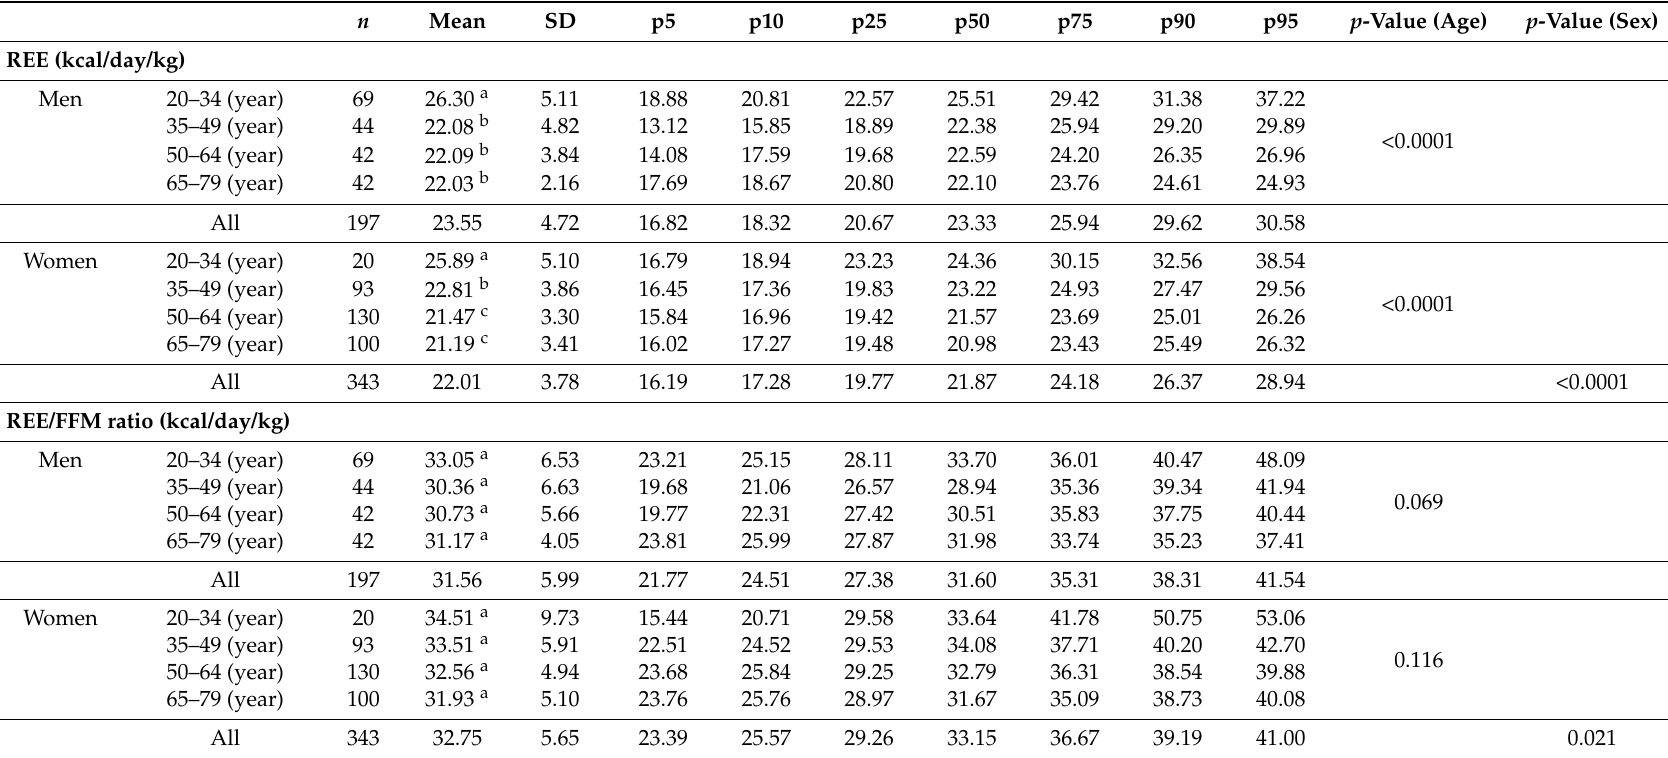
Table 3. Gender- and age-specific REE and REE/FFM